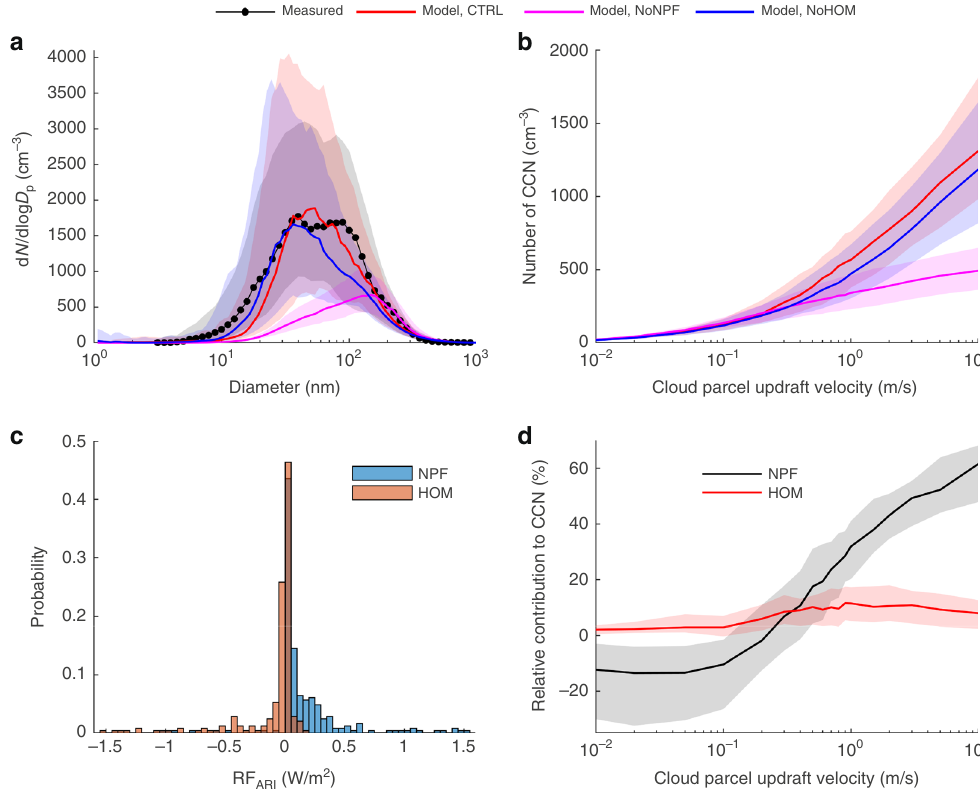
Fig. 7 Climate implications of highly oxygenated organic molecules (HOM). Model and measurement results covering the conditions during the periods 15 – 24 May 2013 and 15 April to 5 May 2014 at the Station for Measuring Ecosystem-Atmosphere Relations II (SMEAR II). Panel a shows the measured and modelled median particle number size distributions, b modelled median Cloud Condensation Nuclei (CCN) number concentrations as a function of cloud parcel updraft velocity, c modelled top of the atmosphere direct aerosol radiative forcing probability distributions caused by new particle formation (NPF) and HOM secondary organic aerosol (HOM SOA) formation, during clear sky conditions, and d relative fraction of the modelled CCN number concentrations that are caused by NPF and HOM SOA formation, respectively. The model results were derived based on data from the control run (CTRL), the no NPF simulation (NoNPF), and the no HOM formation simulation (NoHOM). The shaded areas in panels a , b and d show the measured and